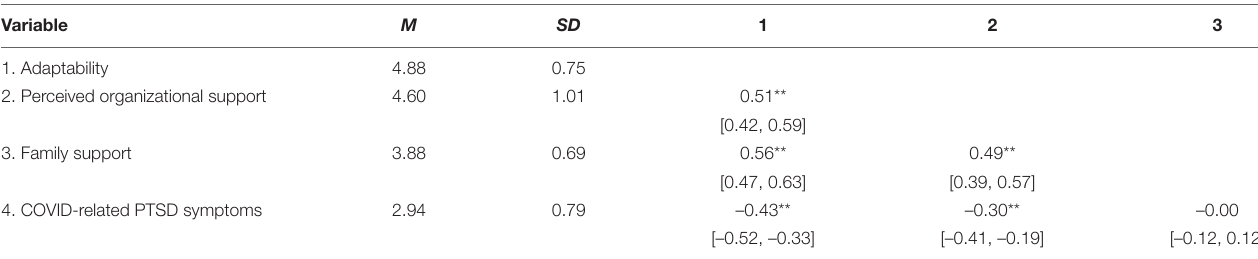
TABLE 1 | Means, standard deviations, and correlations with confidence intervals ( N = 277).